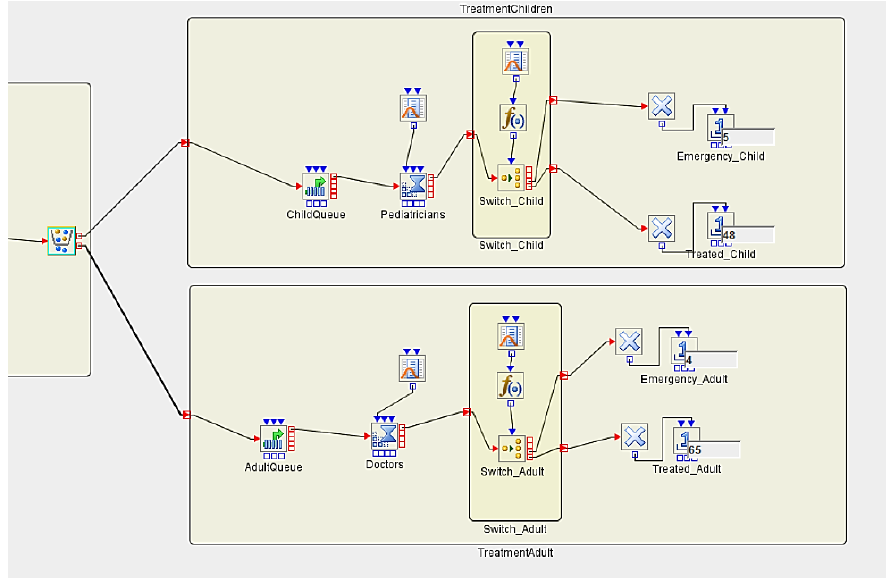
Figure 4. Simulation for an urgent care clinic (third component).